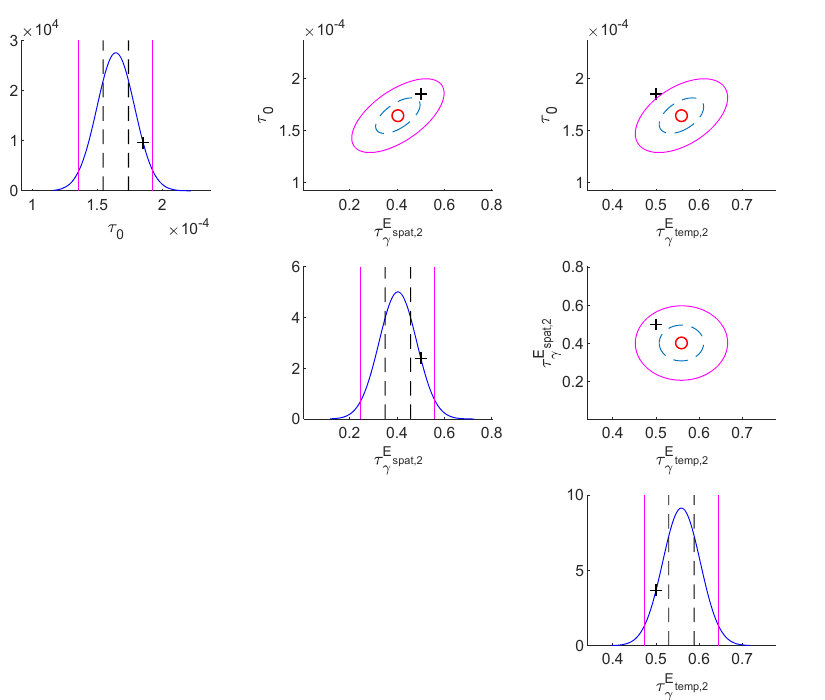
Figure 2. Contour plot of the posterior PDF of the measurement error parameters of the most plausible model class (no damage case).